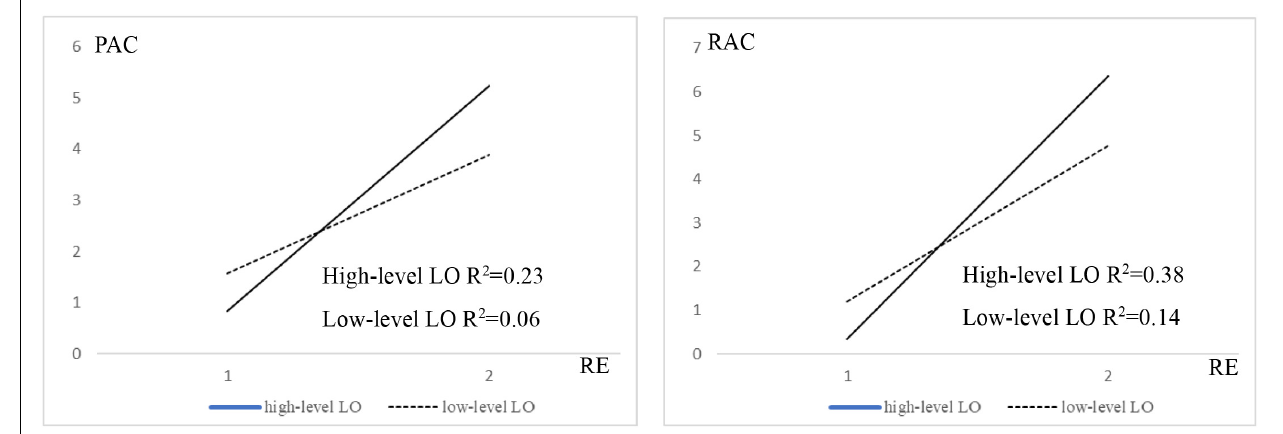
FIGURE 3 | The moderation effects of high-level LO and low-level LO cultures on the links between RE and PAC and RAC.